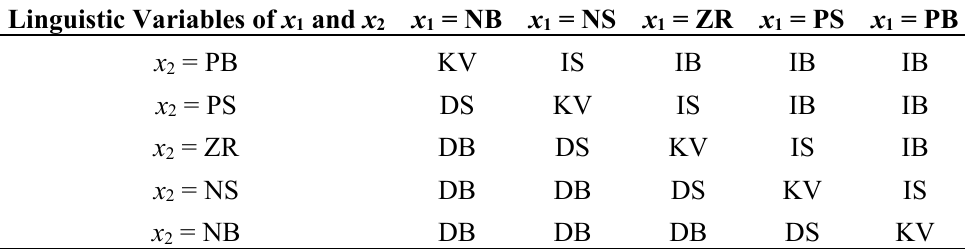
Figure 4. IT2 fuzzy rule-based controller. (Symbol “d” means “derivative”) Table 1. Twenty-five IT2 fuzzy